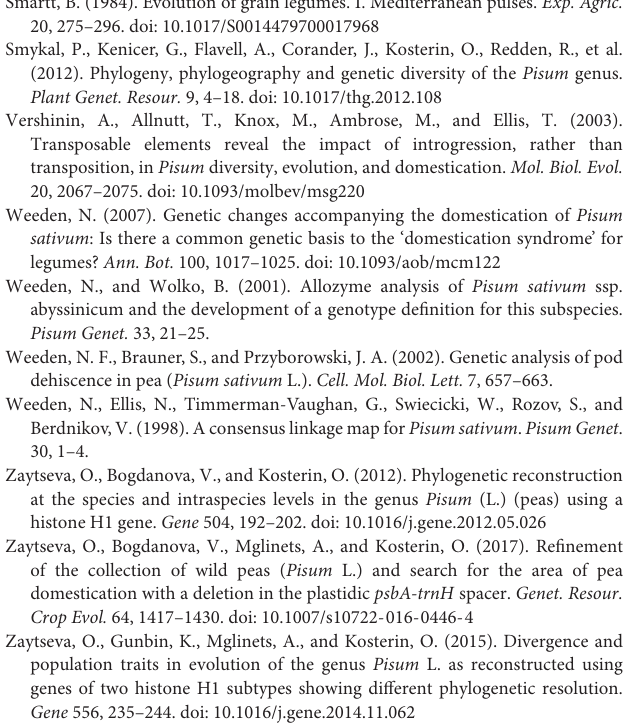
FIGURE S1 | Phylogeny trees for the six genes that indicate a close relationship between the allele from the Abyssinian pea (circled in red) and alleles found in P. sativum ssp. sativum . Alleles from P. fulvum accessions are boxed in blue. The position of each PI accession is presented individually, but those for the modern varieties are lumped into groups labeled Domes1, Domes2, etc. Bar at base of each cladogram represents a nucleotide substitution rate of